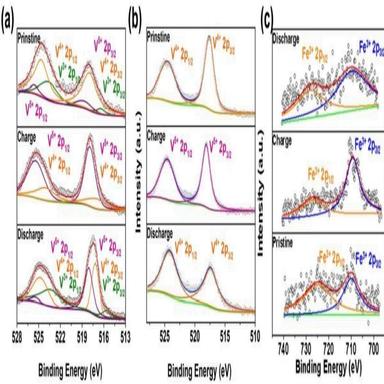
XPS V2p core level spectra charged to 4.3 V and discharged to 2.5 V of (a) NVFPOF; (b) NVPOF; (c) XPS Fe2p core level spectra charged to 4.3 V and discharged to 2.5 V of NVFPOF.